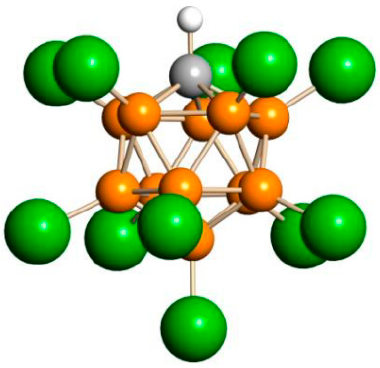
Figure 1. Icosahedral carborane anion CHB 11 Hal 11 − (Hal=F, Cl).